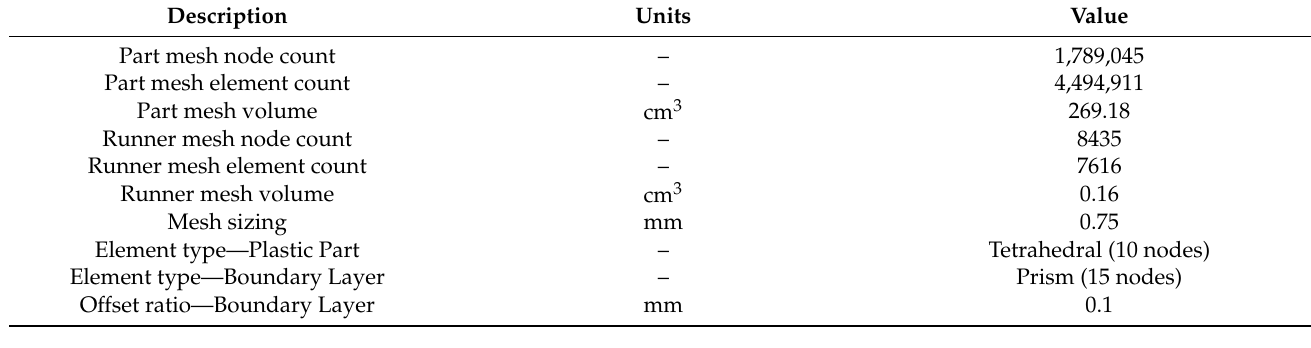
Table 8. Mesh parameters for the standard, conformal, and hybrid cooling systems.